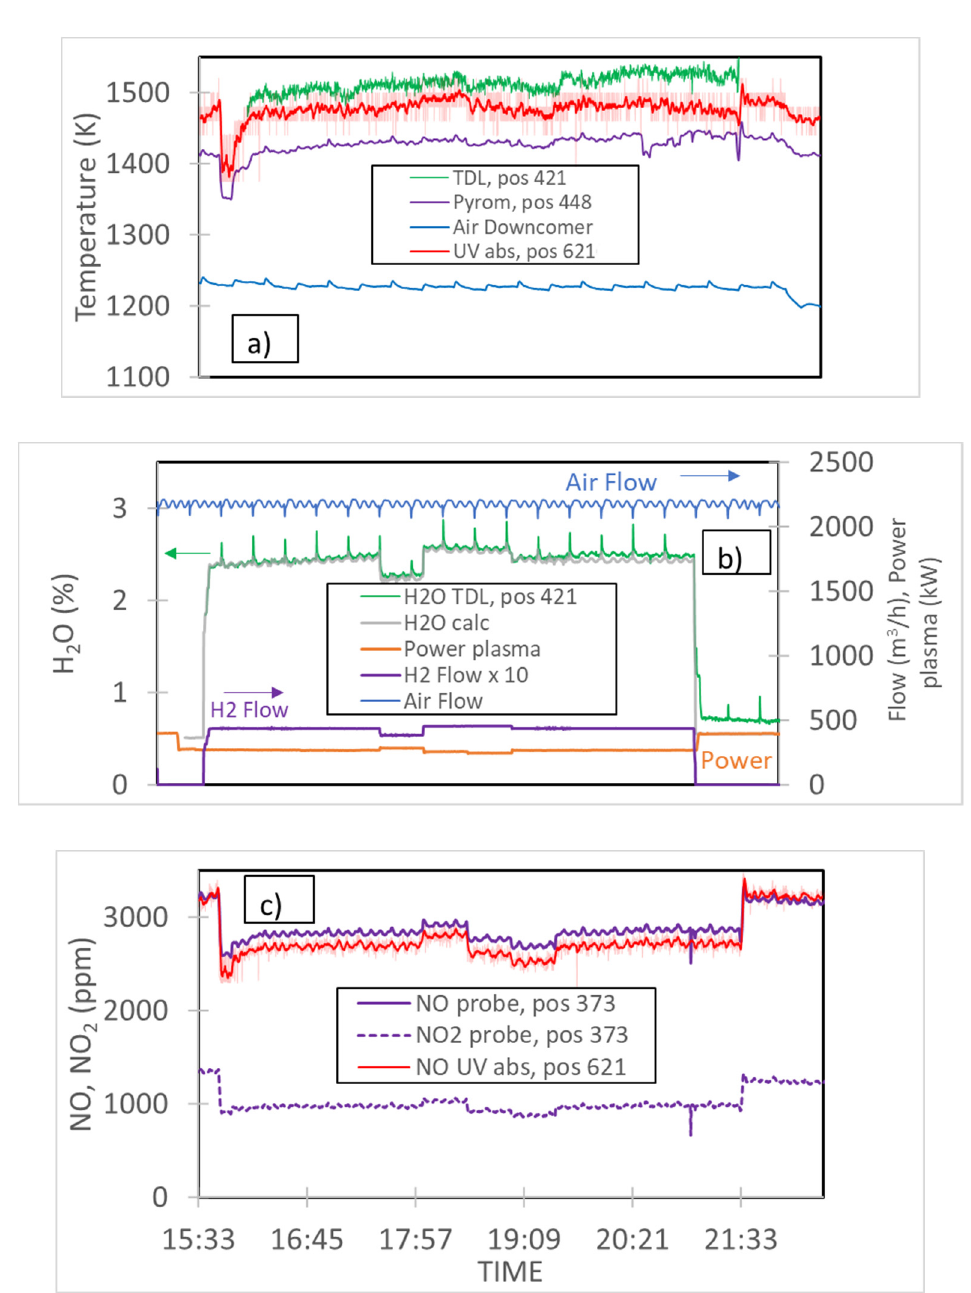
Figure 5. Online measurements of T (TDL, UV absorption, Suction pyrometer, TC) ( a ), H 2 O (TDL), Plasma power and Flows of process air and hydrogen ( b ), NO (UV absorption) and NO and NO 2 (Probe) ( b ) during the Air plasma heating and H 2 combustion. Position number in the legend (pos nnn) shows the distance in cm from the beginning of the ECF to the measurement position.